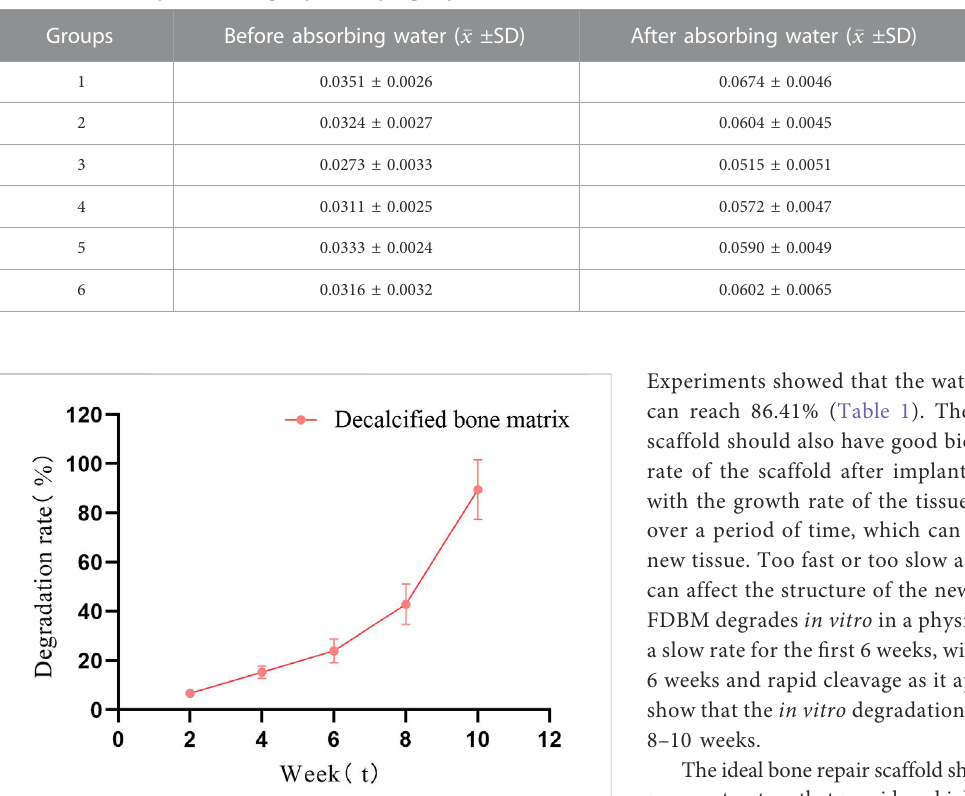
FIGURE 3 Invitro degradationdiagramofFDBM(Thetestwasconductedfora total of 10 weeks, with observations every fortnight.) (n =